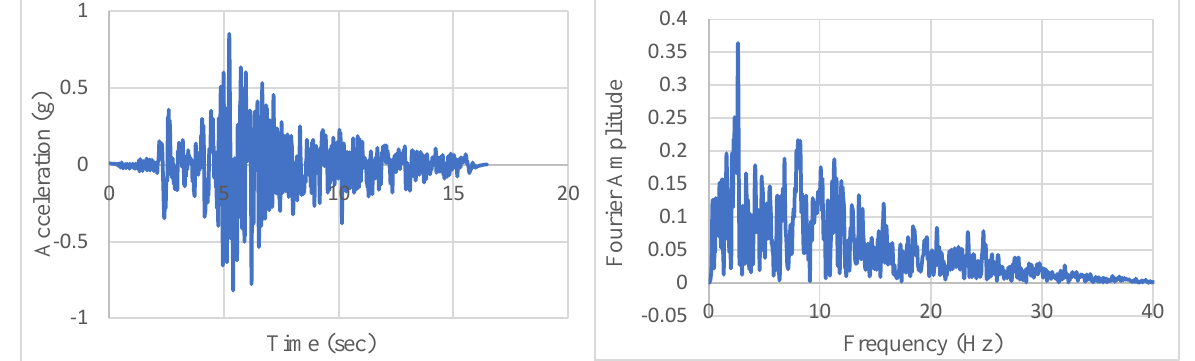
Figure 15. Selected ground motion record and Fourier spectra: Tabas earthquake.